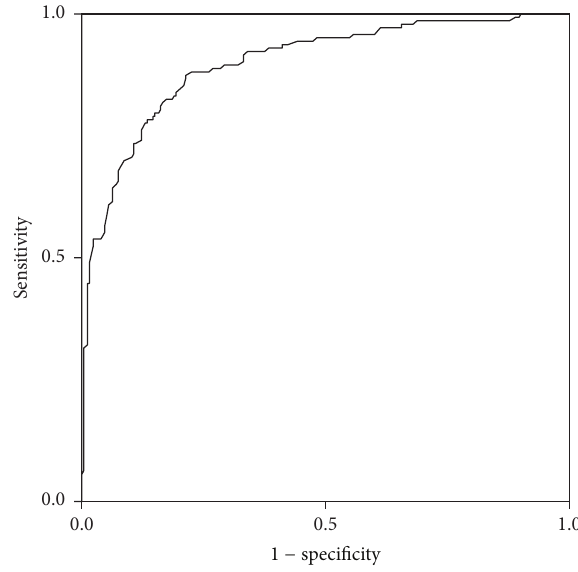
Figure 3: Receiver operating characteristic curve used to predict chronic autoimmune thyroiditis based on shear wave velocity.